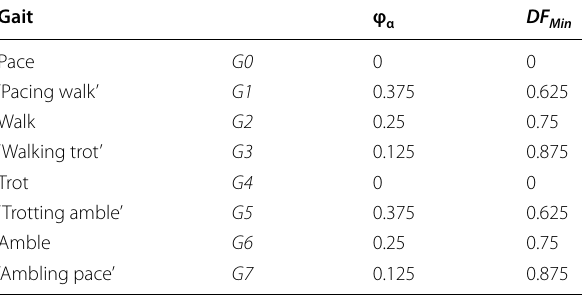
Table 3 The α-phase φ required to achieve four-limb support for each given gait